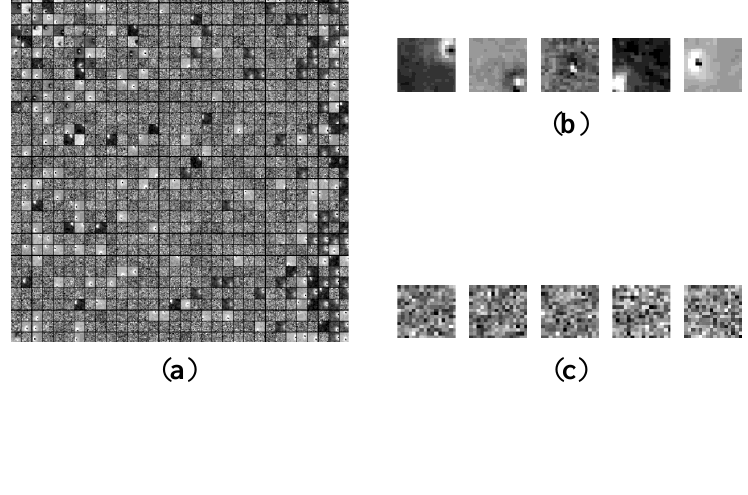
Figure 5. Discriminative over-complete dictionary for space image. ( a ) Dictionary D , ( b ) Target atom of D , ( c ) Background atom of D t b